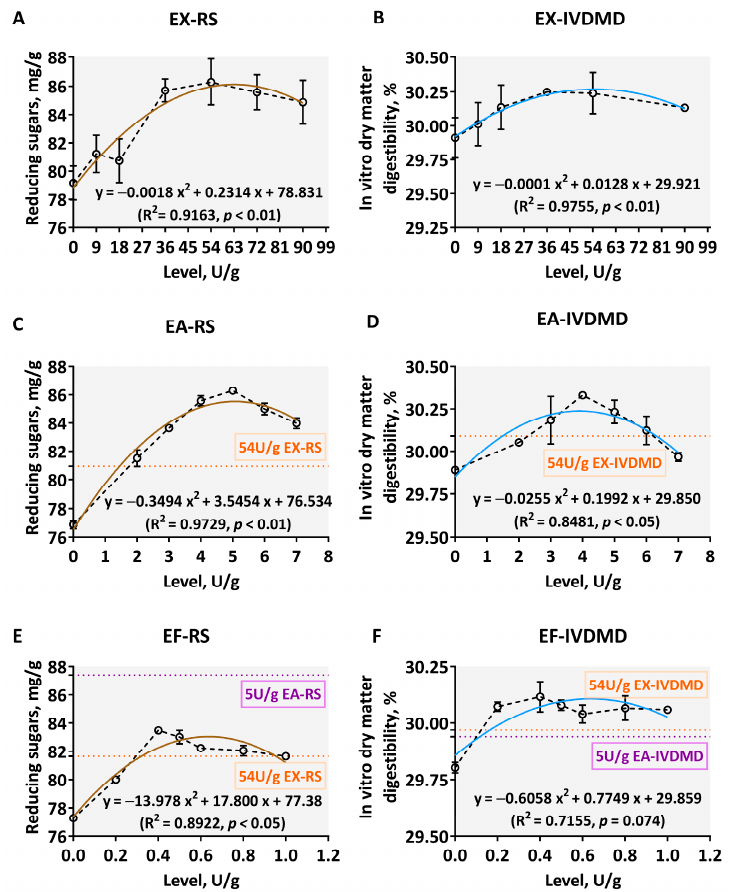
Figure 3. Disassembly degrees of corn AX by different levels of xylan-degrading enzymes. The core EX ( A , B ) and two debranching enzymes (( C , D ): EA; ( E , F ): EF) were produced from Aspergillus niger . The dark brown curves in scatter plots ( A , C , E ) display the reducing sugars (RS) trend, while the light blue ( B , D , F ) represents the fit of in vitro dry matter digestibility (IVDMD). The orange and purple dotted lines show RS or IVDMD indicators corresponding to the hydrolysis of 54 U/g EX and 5.0 U/g EA for this composite substrate, respectively. The data are expressed as the means ± SD.